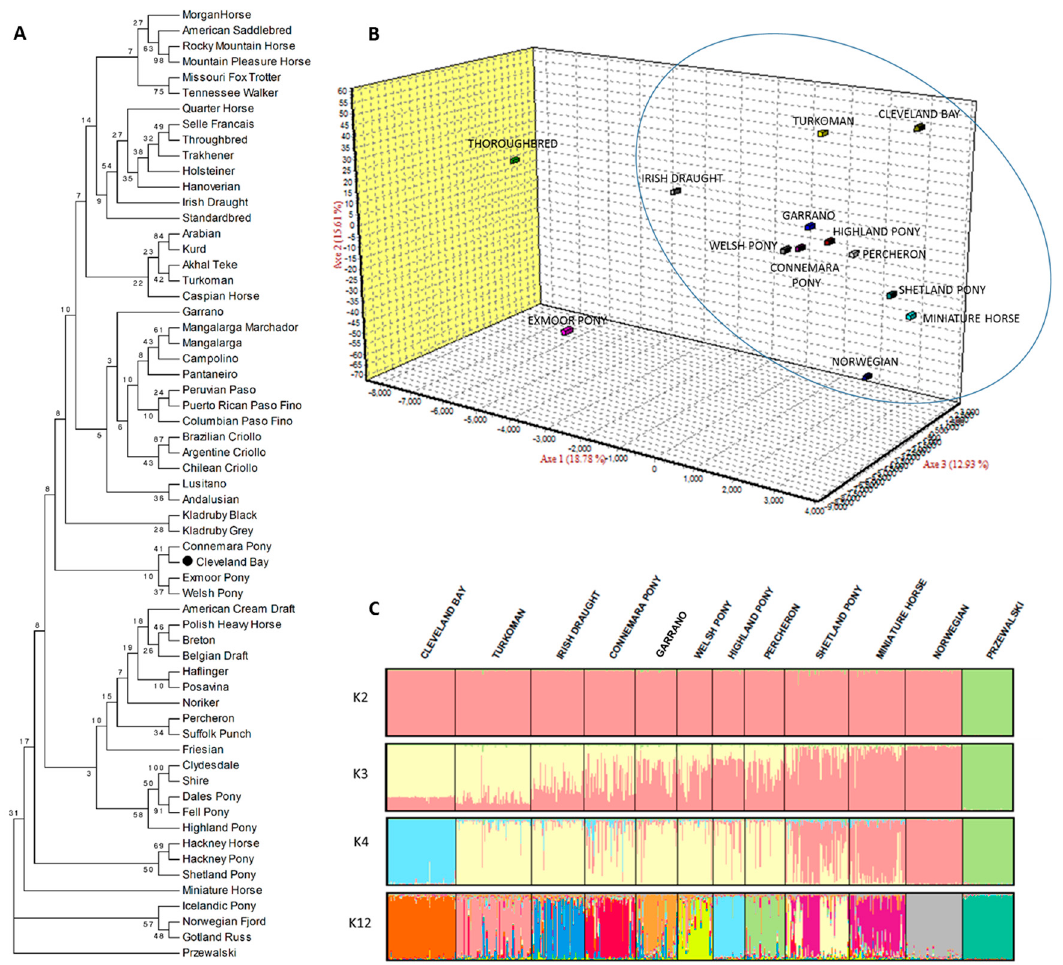
Figure 1. The genetic tree and population structure of the CB breed. ( A ) Dendogram of the genetic relationship among 60 horse breeds and Przewalski as an out-group based on majority-rule consensus RML tree; ( B ) the factorial correspondence analysis of 13 breeds plotted in 3D plot where Axis 1 accounts for 18.78% of the variation. ( C ) Clustering assignment of 11 horse breeds and Przewalski using the Bayesian method. Each individual is represented by a single column which is divided into segments whose size and color represent the relative proportion of the animal genome corresponding to a particular cluster at di ff erent values of